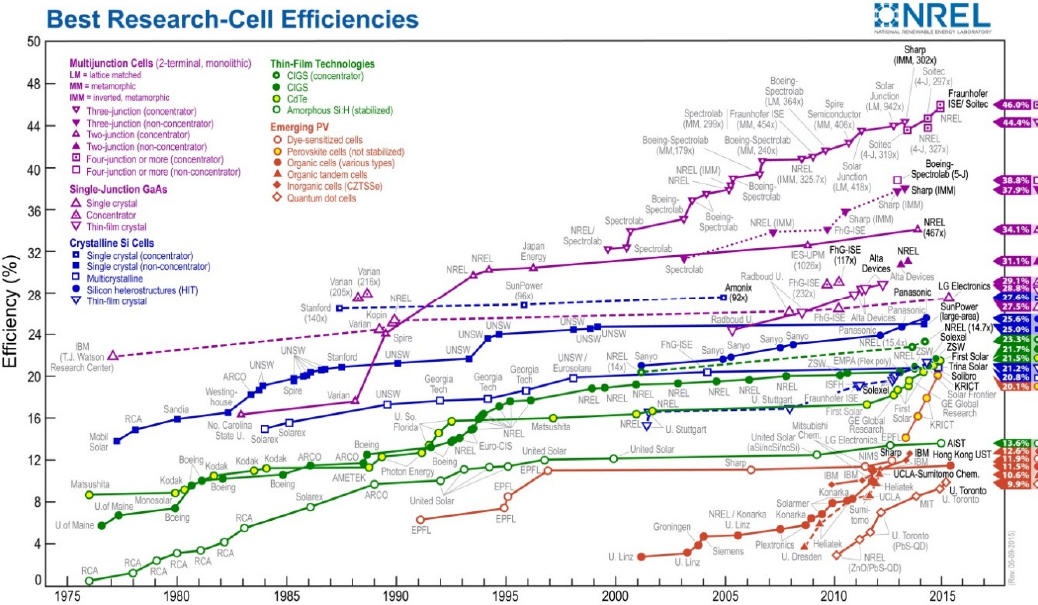
Figure 8. A timeline for reported best research-cell efficiencies, depicting all verified records for various PV conversion technologies like crystalline Si, thin film, single-junction GaAs, multijunction and emerging technologies